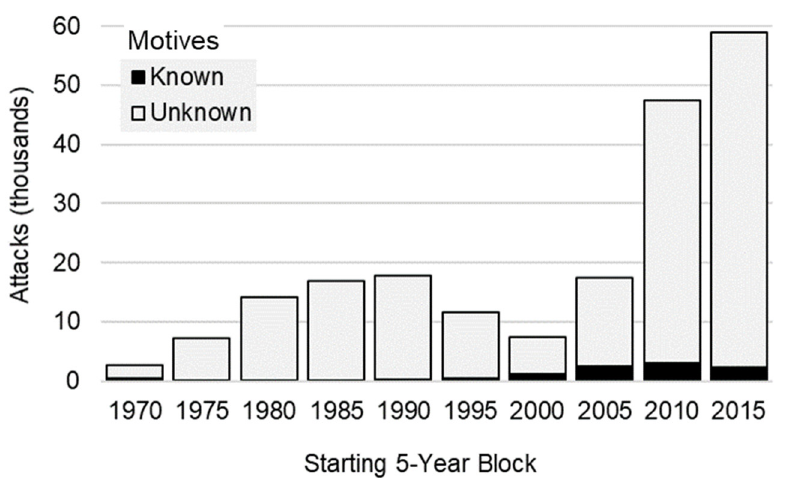
Figure 1. Attacks aggregated by 5-year blocks and motive information from 1970 to 2019.